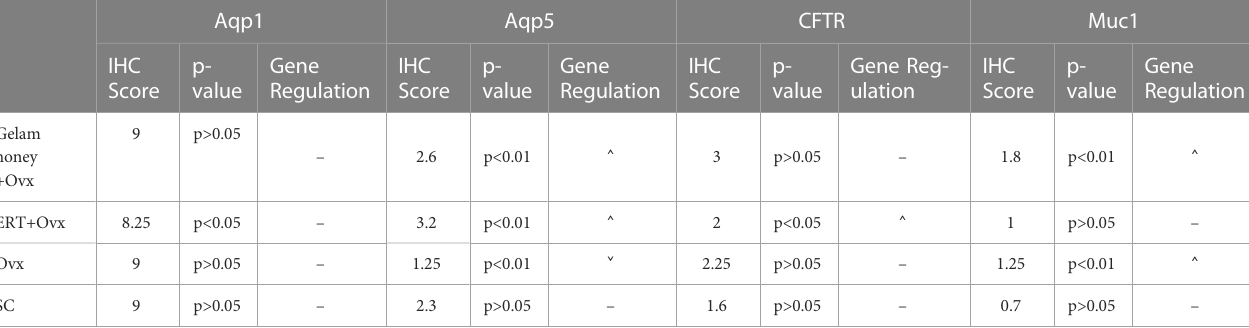
TABLE 1 The immunohistochemistry (IHC) scoring mean values for Aqp1, Aqp5, CFTR and Muc1 proteins in vagina epithelial tissue. The protein scoring is compared to the gene regulation data. Aqp1 Aqp5